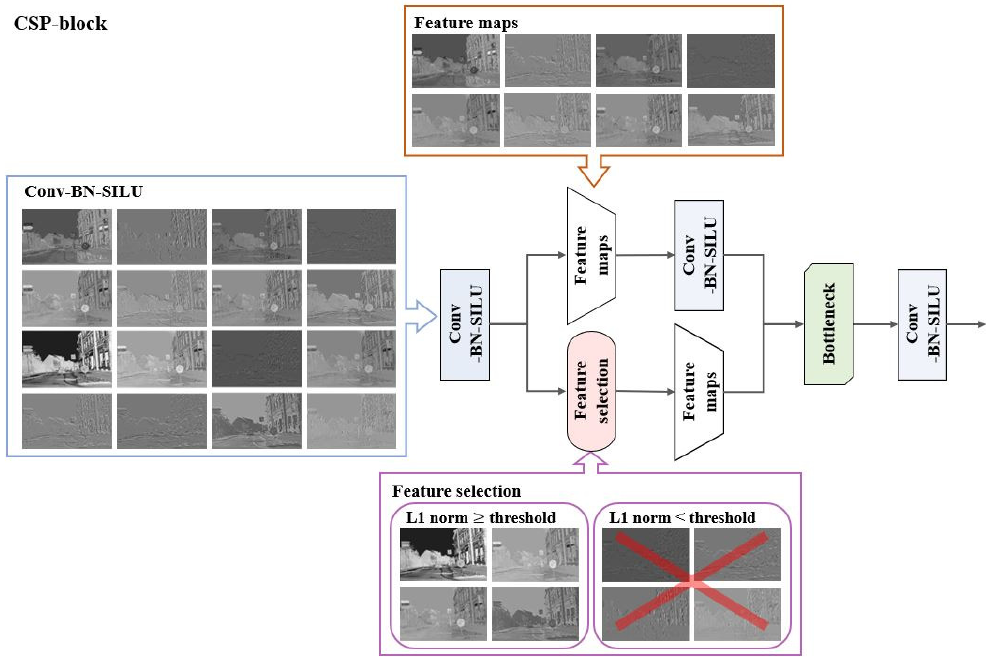
Figure 3. Process of the CSP-block in the CSPDarknet53 using L1-norm feature selection.